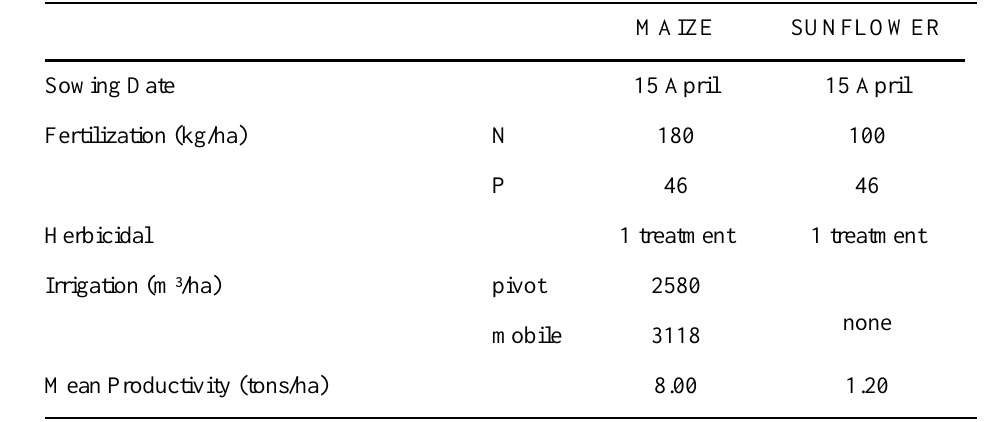
Table 3. Agronomic needs and mean productivity of maize and